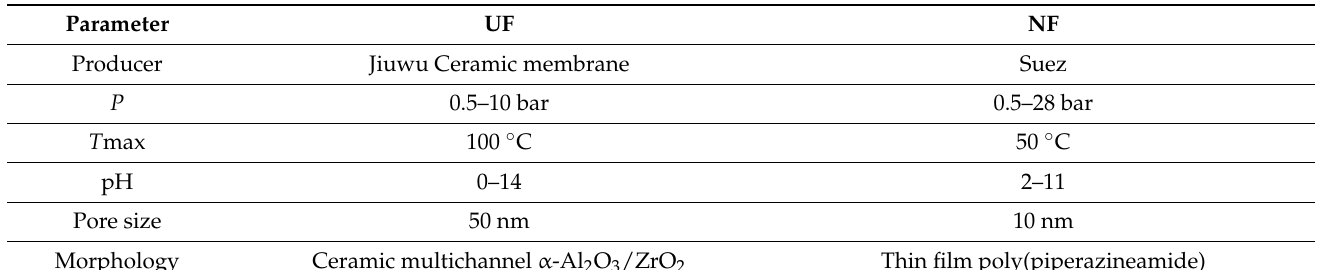
Table 1. The UF and NF membranes’